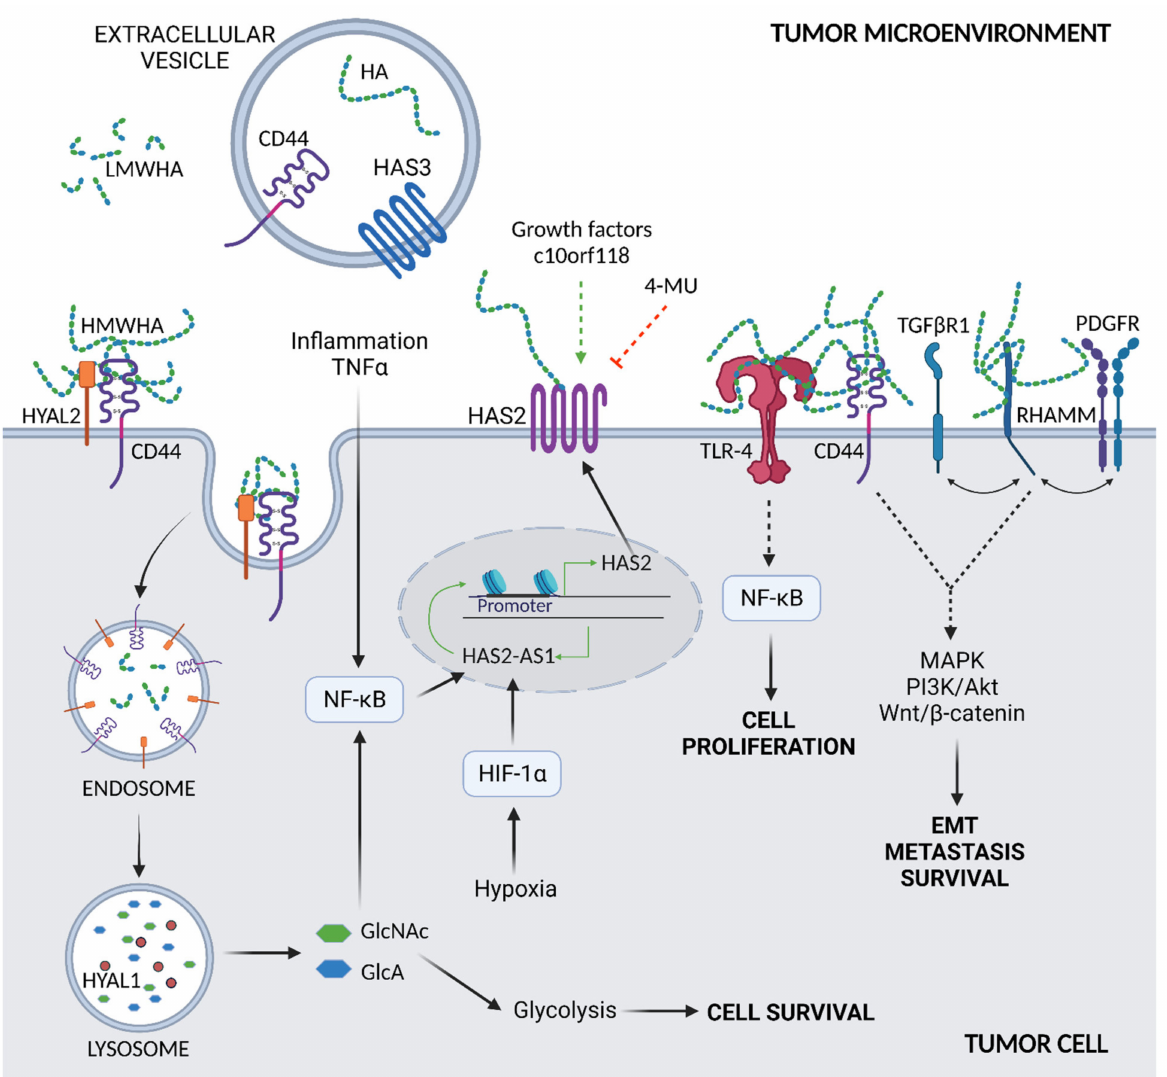
Figure 2. Overview of HA metabolism and interaction with membrane receptors. Synthesis of HA by HAS2, the main synthetic enzyme in cancer cells, is increased by inflammatory agents, such as TNF α , via the NF- κ B signaling pathway. Induction of HAS2 also occurs due to various growth factors and the secreted protein c10orf118 in a not yet fully described mechanism. Pharmacological agents, such as 4-MU, inhibit HA synthesis and downregulate HAS2. A binding to HYAL2 and CD44 and endocytosis lead to the degradation of HMWHA; HYAL2 cuts HMWHA into fragments (LMWHA) at the plasma membrane which, in turn, are internalized into the cell via endocytosis and further degraded by HYAL1 in lysosomes. The produced sugars, GlcNAc and GlcA, may be recycled in cell energy metabolism, i.e., glycolysis, or control HAS2-AS1 expression via NF- κ B. HAS2-AS1 is also regulated by hypoxia via HIF-1 α . Tumor cells are secreted in tumor microenvironment extracellular vesicles that contain HA, HAS3, and CD44 that can be captured by target cells. The HA of the tumor microenvironment can bind to different cell membrane receptors. The HA–TLR-4 complex signals the NF- κ B pathway, supporting cell proliferation, whereas HA-CD44 and HA-RHAMM interact with either TGF β RI and PDGFR, promoting EMT and cell survival and